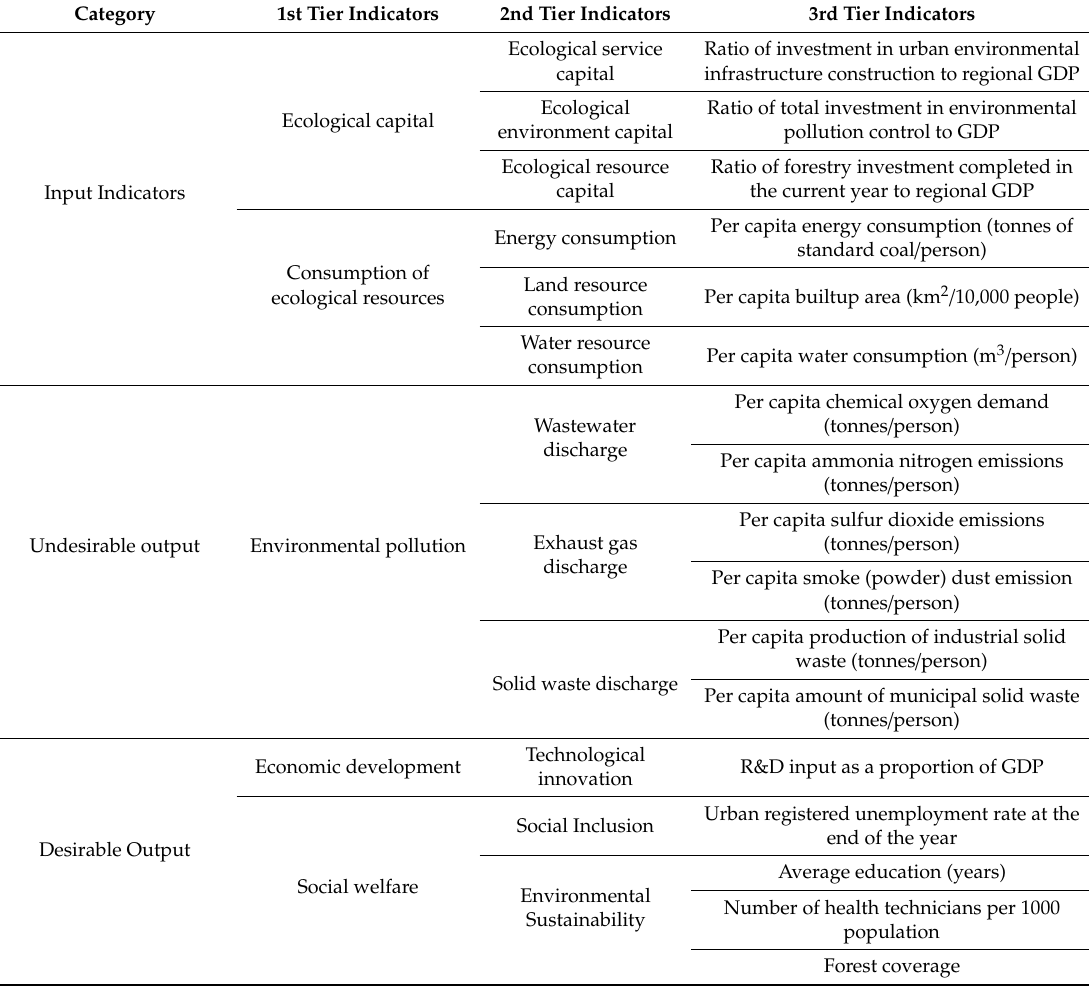
Table 2. Main characteristics for the EWP input-output